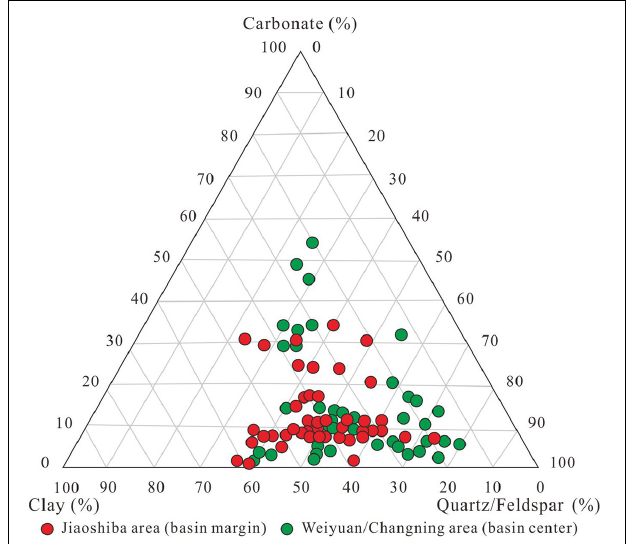
FIGURE 2 | A ternary diagram showing mineral compositions of shale samples in the Sichuan Basin (the data of Jiaoshiba area was referenced from Guo et al. (2014)).